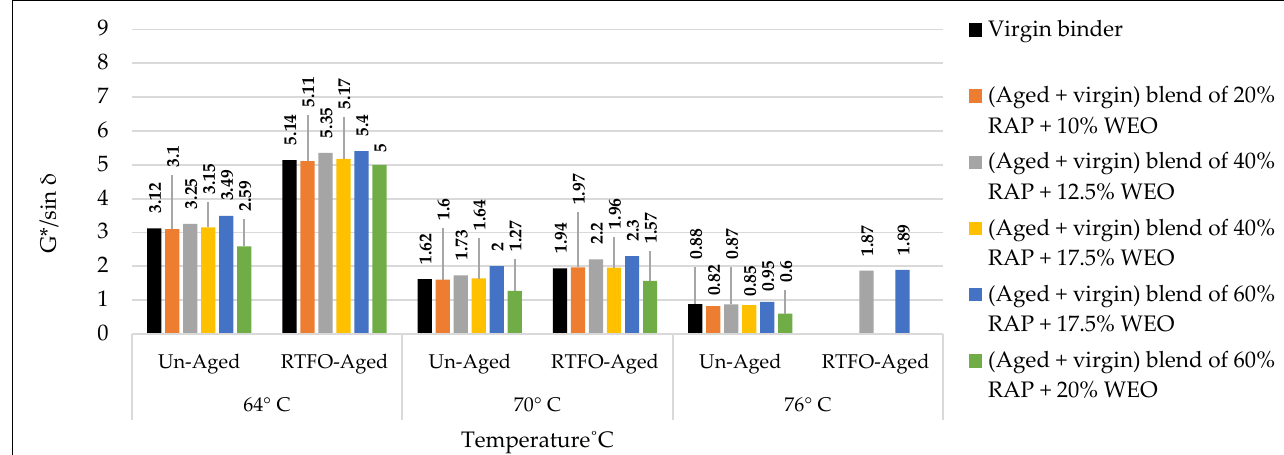
Figure 23. Rutting index (G*/sin δ ) for the aged blends of binders rejuvenated by DSO. 4.